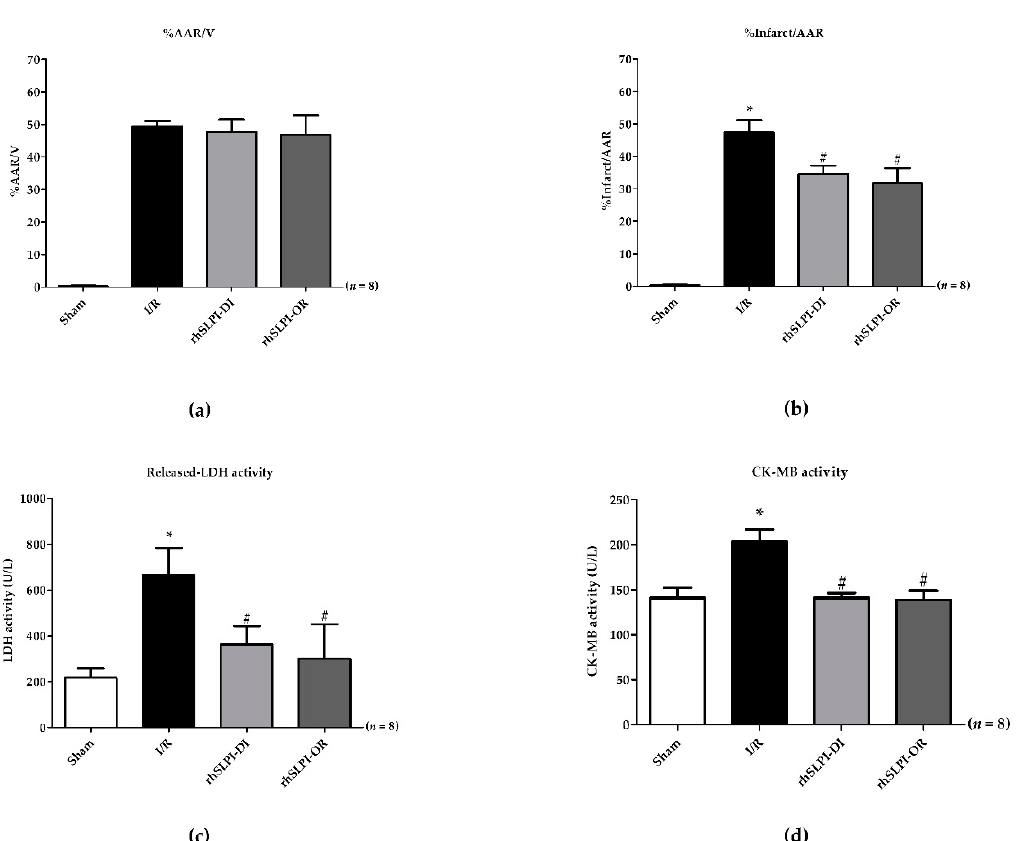
Figure 3. Determination of the percentage of area at risk (AAR) to ventricle volume (V) ( a ), percentage of infarct size to area at risk ( b ), activity of Lactate Dehydrogenase (LDH) ( c ) and Creatine kinase-MB (CK-MB) ( d ) (* p < 0.05 vs. sham) ( # p < 0.05 vs. I/R) ( n = 8).